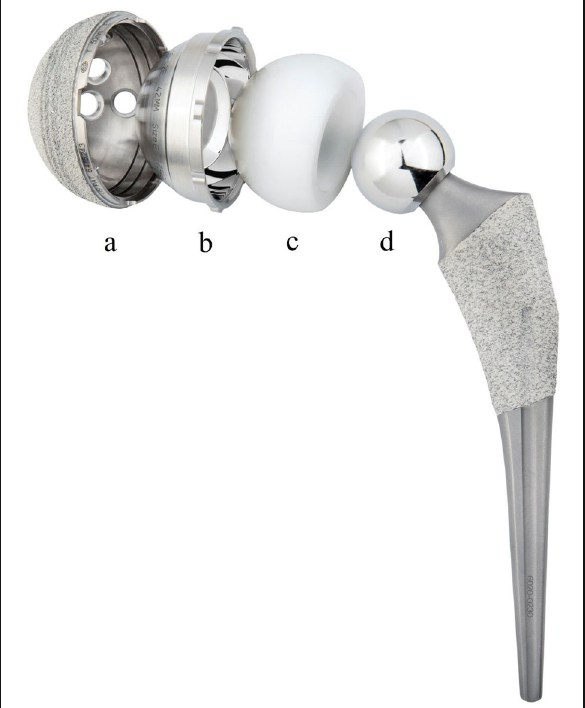
Fig. 1 The modular dual mobility (DM) used in the current study ( a , acetabular cup; b , modular DM liner; c , polyethylene insert; d , femoral